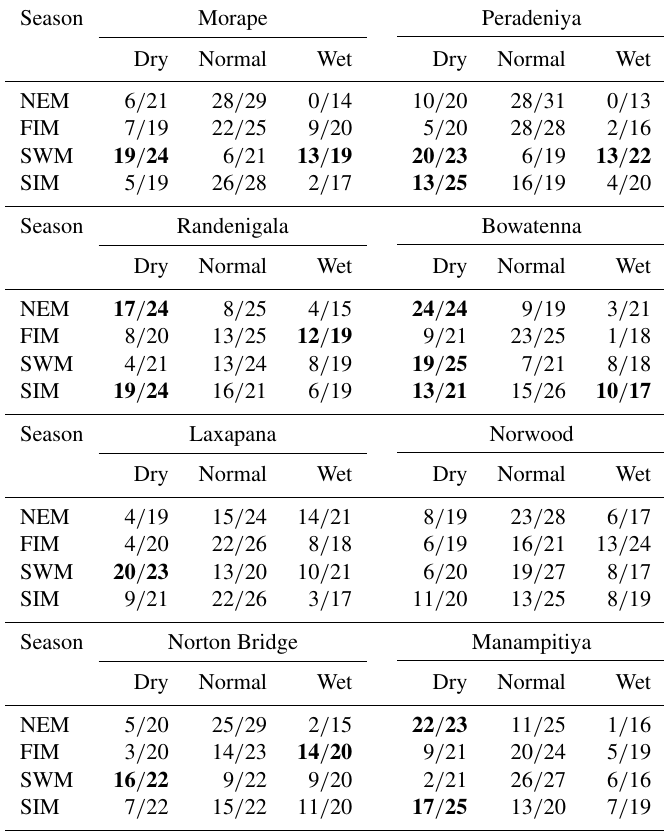
Table A4. Classification QDA model results. Highlighted cells indicate where there may be information content with respect to forecasting either dry or wet anomaly